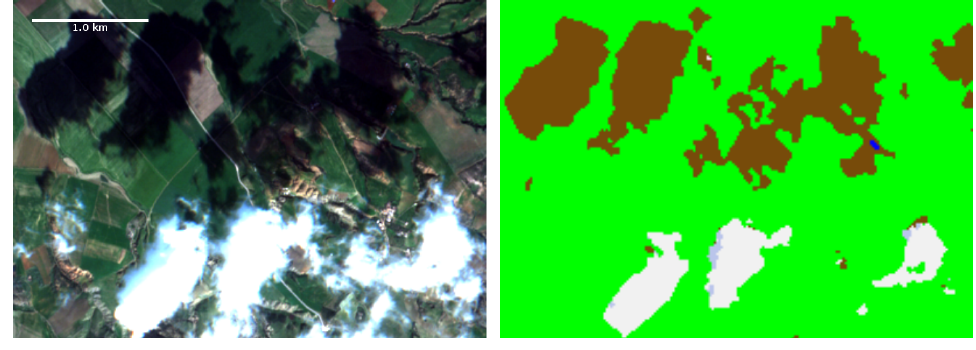
Figure 9. Three scene classification comparison between L1C RGB patches and ML classified images: ( a ) Ballyhaunis, Ireland, ( b ) Sukabumi. Indonesia, and ( c ) Béja, Tunisia. Color Labels: Shadow (Brown), Cloud (White), Other